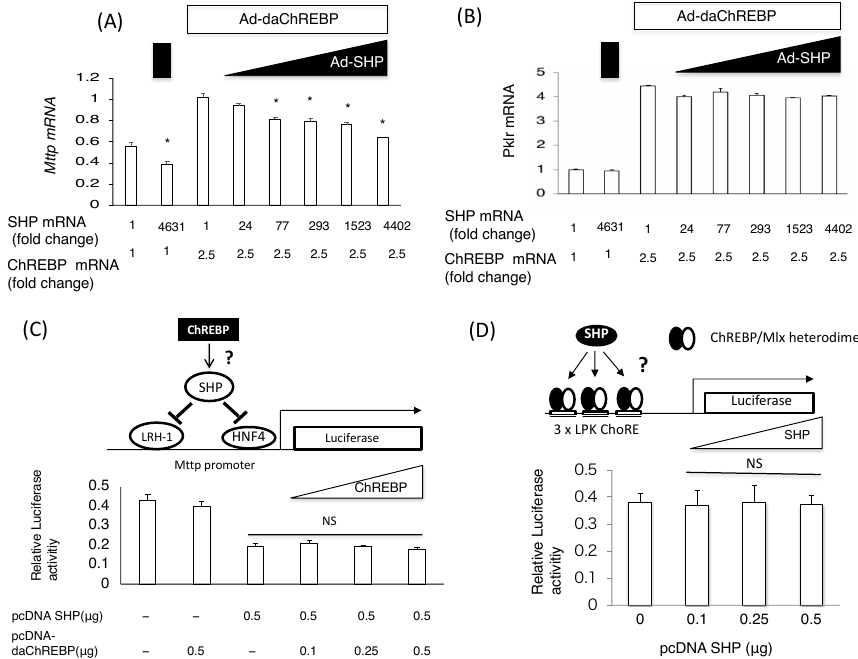
Figure 1. The coordinated effects of carbohydrate response element binding protein (ChREBP) and small heterodimer partner (SHP) on Mttp expression. ( A ) and ( B ) The effects of SHP on ChREBP-mediated Mttp ( A ) and Pklr ( B ) mRNA induction. After 4 h infection with Ad-daChREBP and/or Ad-SHP in hepatocytes, cells were incubated for 20 h. Mttp mRNA levels were detected by real-time Polymerase chain reaction method. Open symbols and closed symbols indicated adenoviral overexpression of daChREBP and SHP, respectively. The x -axis indicates Shp and Chrebp mRNA levels (fold change). Adenoviral overexpression of ChREBP caused a 2.5-fold increase in Chrebp mRNA levels. Adenoviral SHP expression caused an indicated fold increase in Shp expresssion. Pol2 expression was used as an internal control. n = 4 per group. * p < 0.05; ( C ) Reporter assay using pGL3-Mttp ( − 211 bp). The indicated amounts of pcDNA-daChREBP and pcDNA-SHP were transfected with pGL3-Mttp ( − 211 bp) and pRL-TK vectors and Lipofectamine 2000 reagent into primary rat hepatocytes. After 24 h incubation, cells were collected for the dual luciferase assay. Luciferase activity was normalized to Renilla luciferase activity. N.S., not significant. n = 6 per group; ( D ) Reporter assay using pGL3 3 × LPK ChoRE. The indicated amount of pcDNA-SHP was cotransfected with pGL3-3 × LPK ChoRE, PRL-TK, pcDNA daChREBP, and Lipofectamine 2000 into primary rat hepatocytes. After 24 h incubation, cells were collected for the dual luciferase assay. Luciferase activity was normalized to Renilla luciferase activity. NS, not significant vs control. n = 6 per